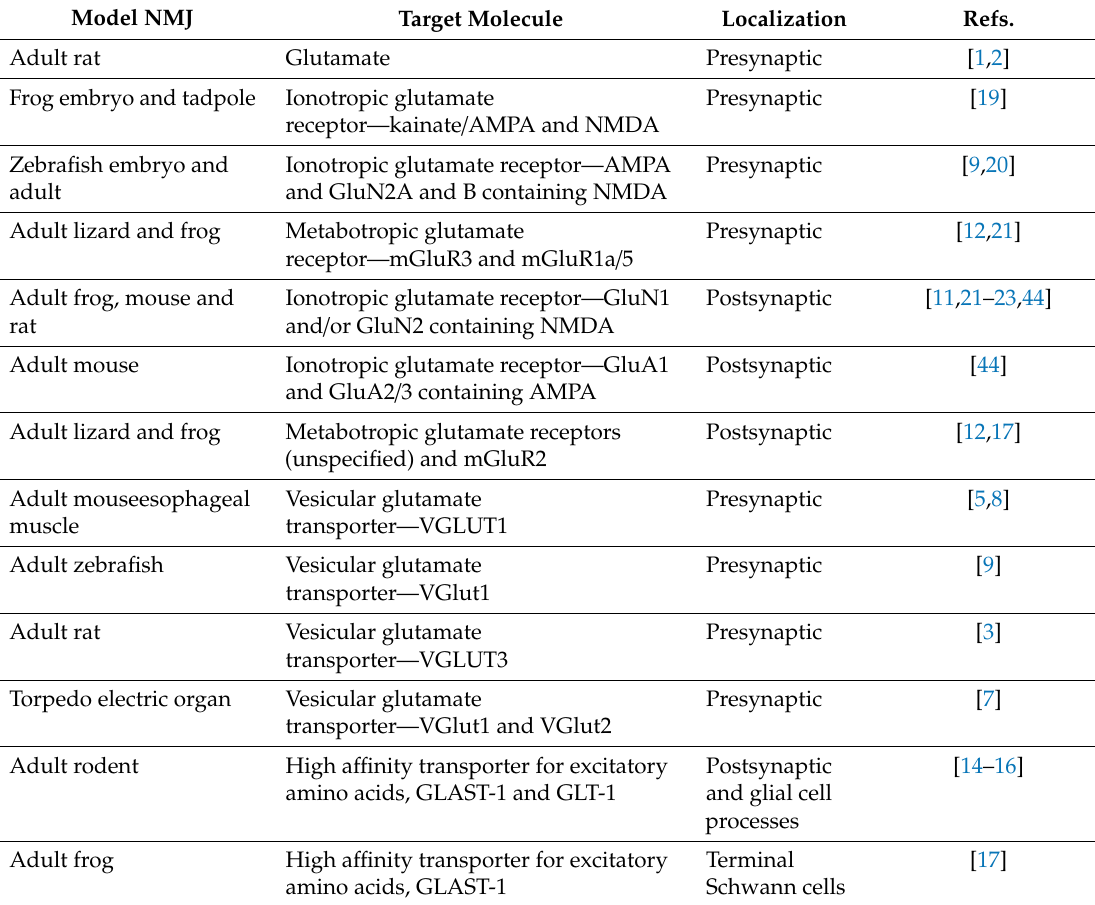
Table 1. Glutamate signaling machinery at the vertebrate neuromuscular